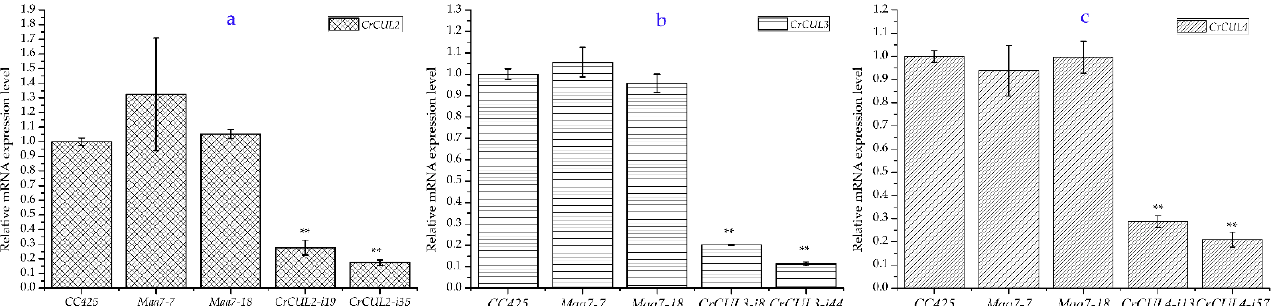
Figure 4. The expression levels of CrCUL s decrease in RNAi transformants. Relative mRNA expression levels of CrCUL s were analyzed by real-time RT-PCR analysis, ( a ) for the CrCUL2 gene, ( b ) for the CrCUL3 gene, ( c ) for the CrCUL4 gene. Three experiments were performed with the CC425 strain as the control. Error bars indicate the standard deviation. The asterisks show statistically significant differences by Dunnett’s multiple range test; ** p ≤ 0.01.